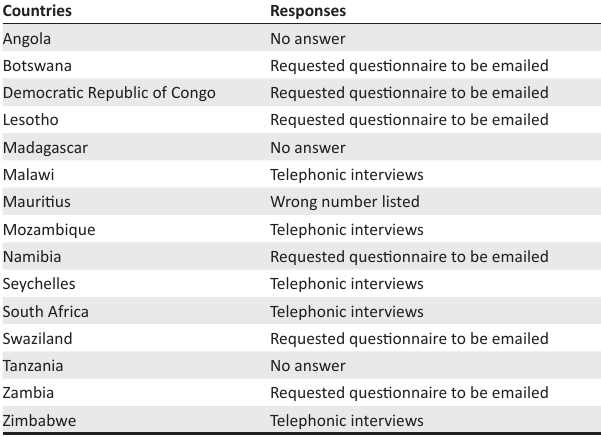
TABLE 6: Interviews with heads of national disaster